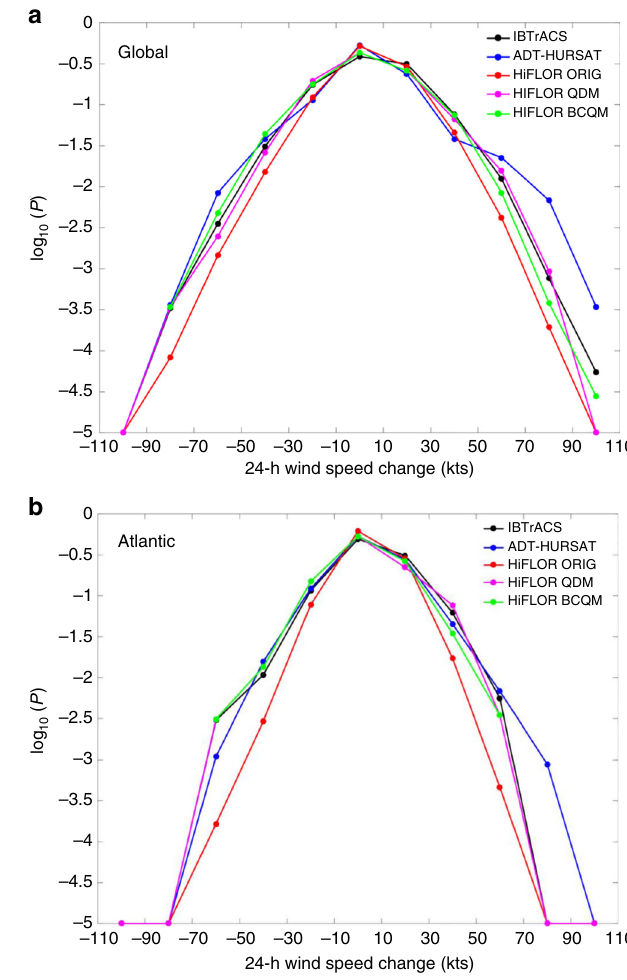
Fig. 3 Rapid intensi fi cation ratio trends. a , b Observed trends in the rapid intensi fi cation (RI) ratio of ADT-HURSAT (black) and IBTrACS (blue) over the 28-year period 1982 – 2009 using a global and b Atlantic data. RI ratio is de fi ned as the number of 24-h intensity changes above 30 knots divided by the total number of 24-h intensity changes. Trends in the time series of the annual mean RI ratio are denoted by dashed lines. The slopes of the trend lines as well as their 90% con fi dence intervals are provided. The slopes and con fi dence intervals are calculated using 1000 randomly perturbed samples of the observational data. Shading represents the 5th and 95th percentiles of the 1000 regressions with these randomly perturbed observational possibly due to the lack of SST nudging or the different years sampled.